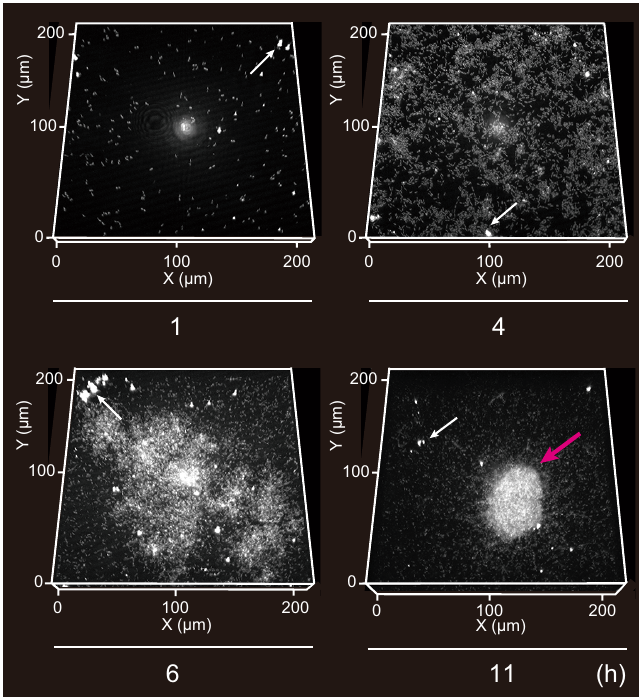
Figure 5. The 3D projection of the initial biofilm formation of P . aeruginosa PAO1 on the MY-133-EA layer at 1, 4, 6, and 11 h. The images were obtained by optical system equipped with a 561-nm continuous wave laser, a 60 × oil-immersion lens (NA = 1.4, RI = 1.515) and a pinhole of 1.2 airy unit. The z-resolution is 0.5 μm. Note that deterioration of NA by IMM was not taken into account to calculate resolution. Red arrow indicates a microcolony (Height = 25 μm). White arrows indicate debris. The 3D projection of 1, 4, 6 and 11 h, illustrates the range of 0 μm (i.e. surface) to 11, 11, 21, 41 μm of height along the vertical z-axis,